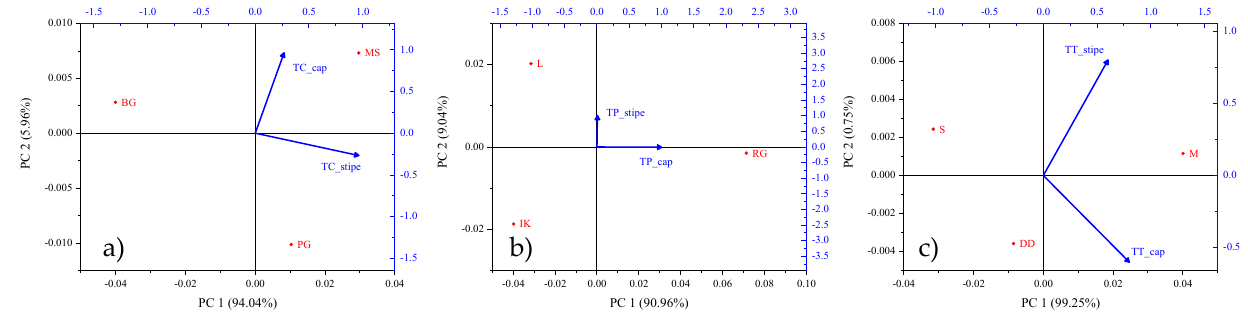
Figure 3. PCA biplot showing interactions between sampling locations and Cd contents in the cap and stipe parts of Tricholoma spp. (( a ) T. columbetta , ( b ) T. portentosum , and ( c ) T. terreum ). Table 3. PCA matrix for Cd concentration in cap and stipe parts of Tricholoma spp. Principal Component Mushroom Species Variables PC 1 PC 2 T. columbetta ( n = 38)